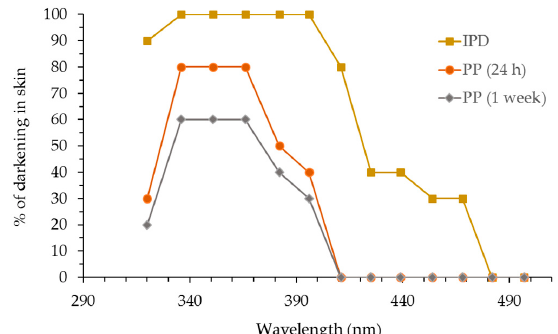
Figure 2. Percentages of immediate pigment darkening (IPD) and persistent pigmentation (PP). Positivity of PP was estimated visually at 24 h and 1 week after irradiation.